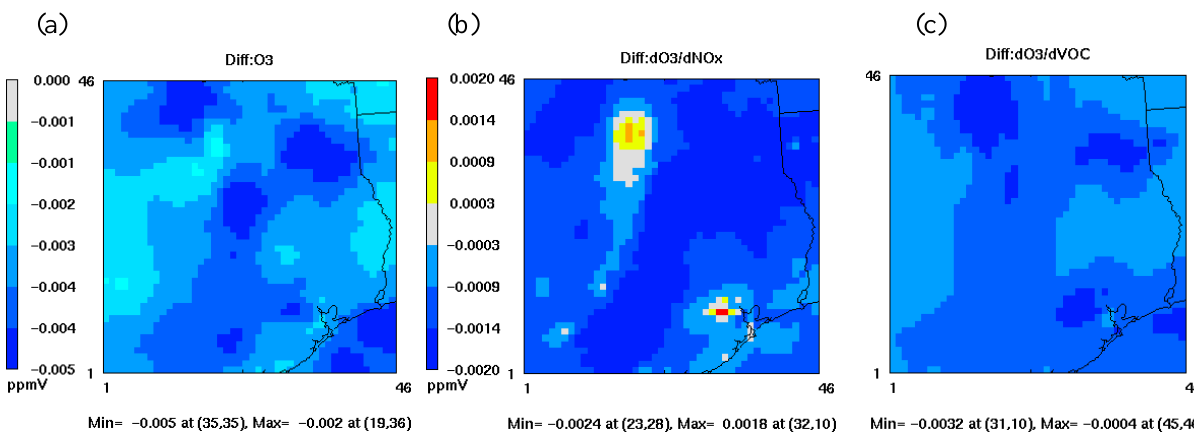
Figure 10. Monthly 8h (10:00–18:00LT) averaged differences in modeled (a) ground O 3 concentrations, (b) O 3 sensitivity to NO x , and (c) O 3 sensitivity to VOC resulting from use of both satellite-derived photolysis rates and NO x emissions in place of a priori